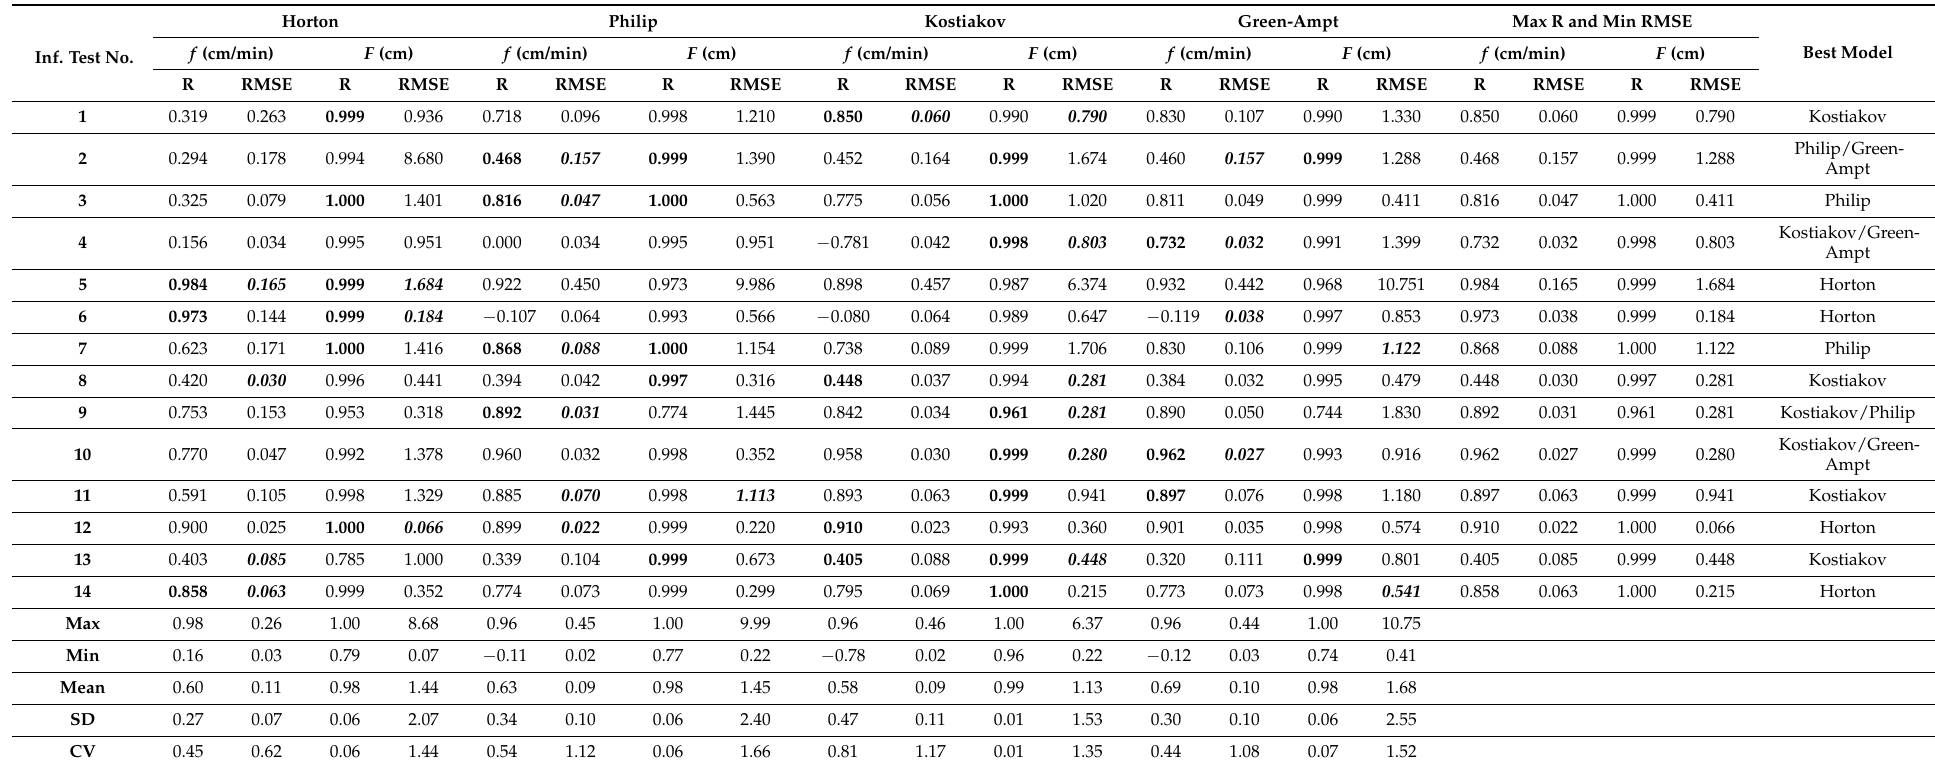
Table 2. Statistical measures of the performance of the infiltration